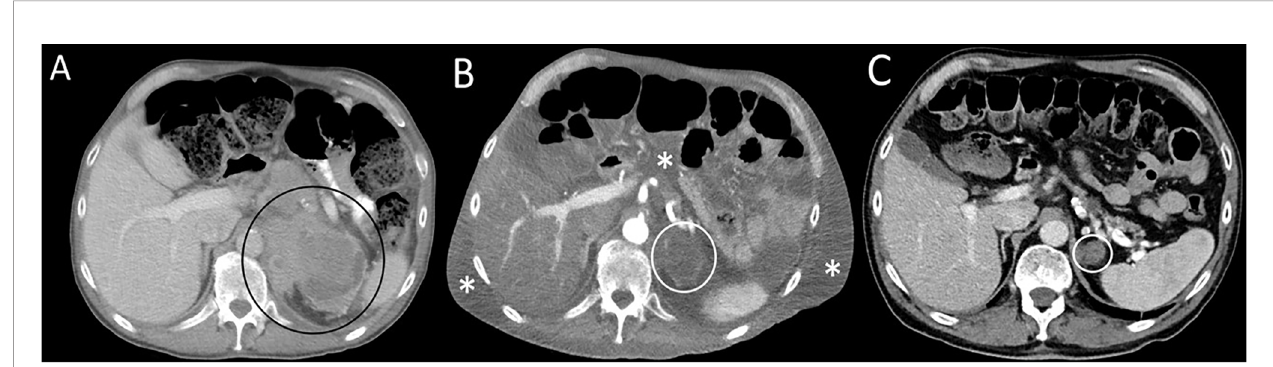
FIGURE 1 | Serial axial computed contrast-enhanced computed tomography (CT) images of the upper abdomen demonstrate (A) a left adrenal mass (circle) 4 months before admission and prior to treatment, (B) decreased tumor size by more than 50% (circle) as well as new-onset ascites and soft tissue edema (asterisks) at the time of hospital admission following therapy with combination immune checkpoint inhibitor therapy; (C) resolution of ascites and soft tissue edema and continued tumor response (circle) 8 months after admission. The patient was not receiving therapy at the time of the follow-up